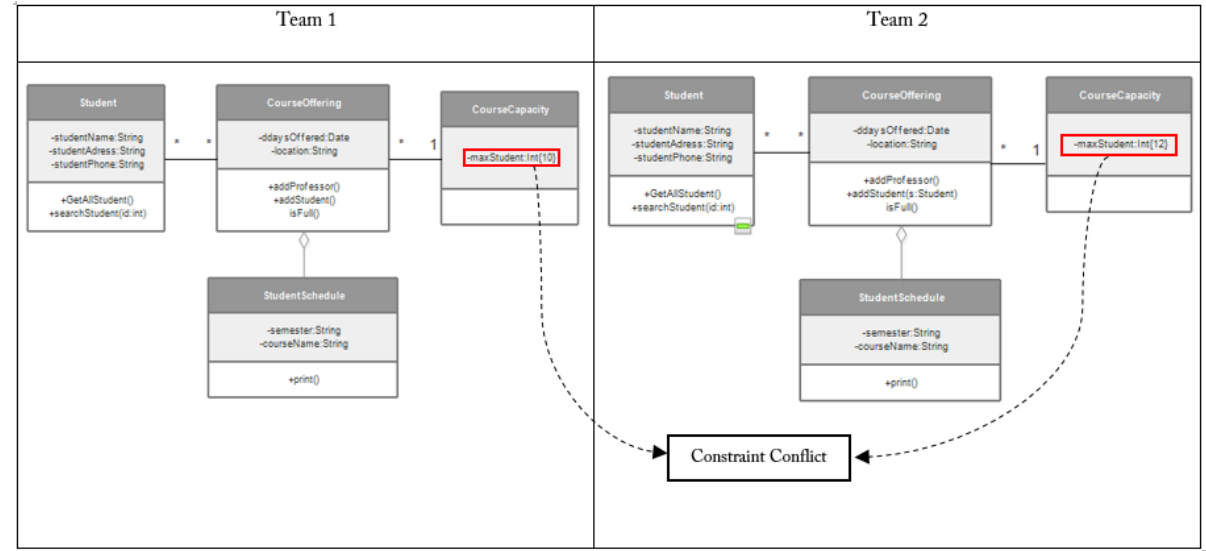
Fig. 6. An example of constraint conflict during the composition process of two class